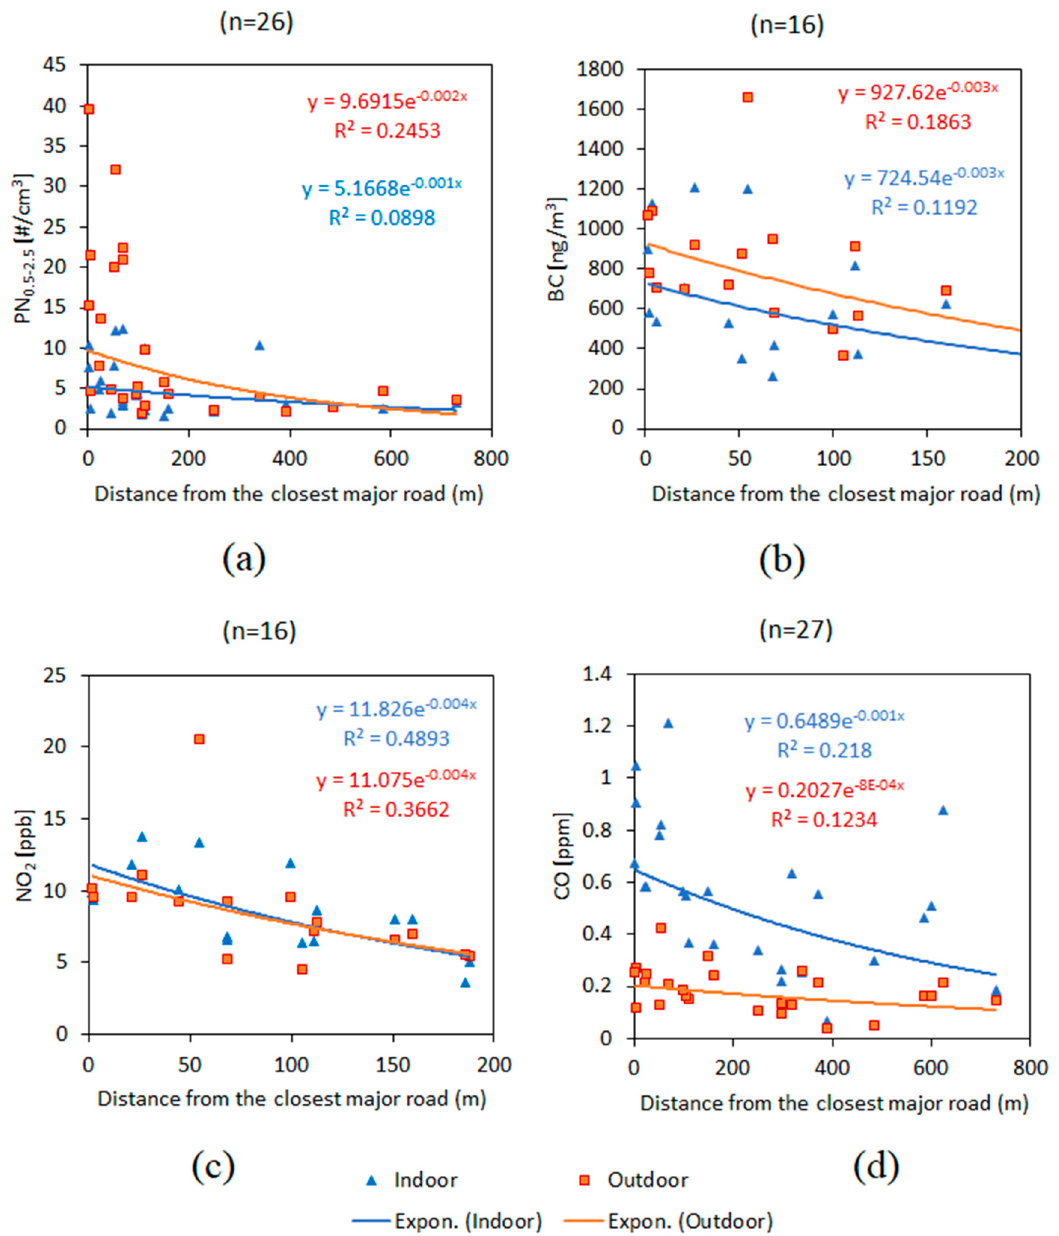
Figure 8. Pollutant concentrations as a function of distance from the closest major road (exponential curve-fitting) for ( a ) PN 0.5–2.5 , ( b ) BC, ( c ) NO 2 , ( d ) CO. This dataset does not include the three homes with gas stoves.